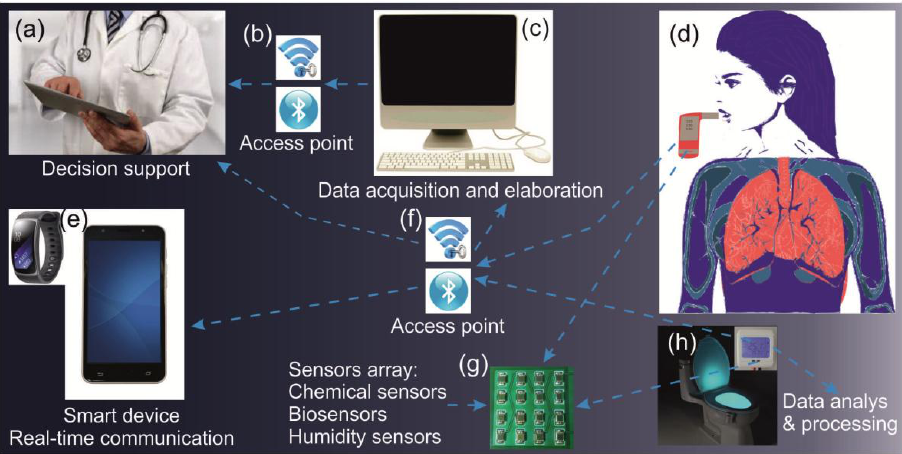
Figure 4. ( a – g ) the design and architecture of medical CCS for the breath analysis. ( h ) A smart toilet for the analysis of